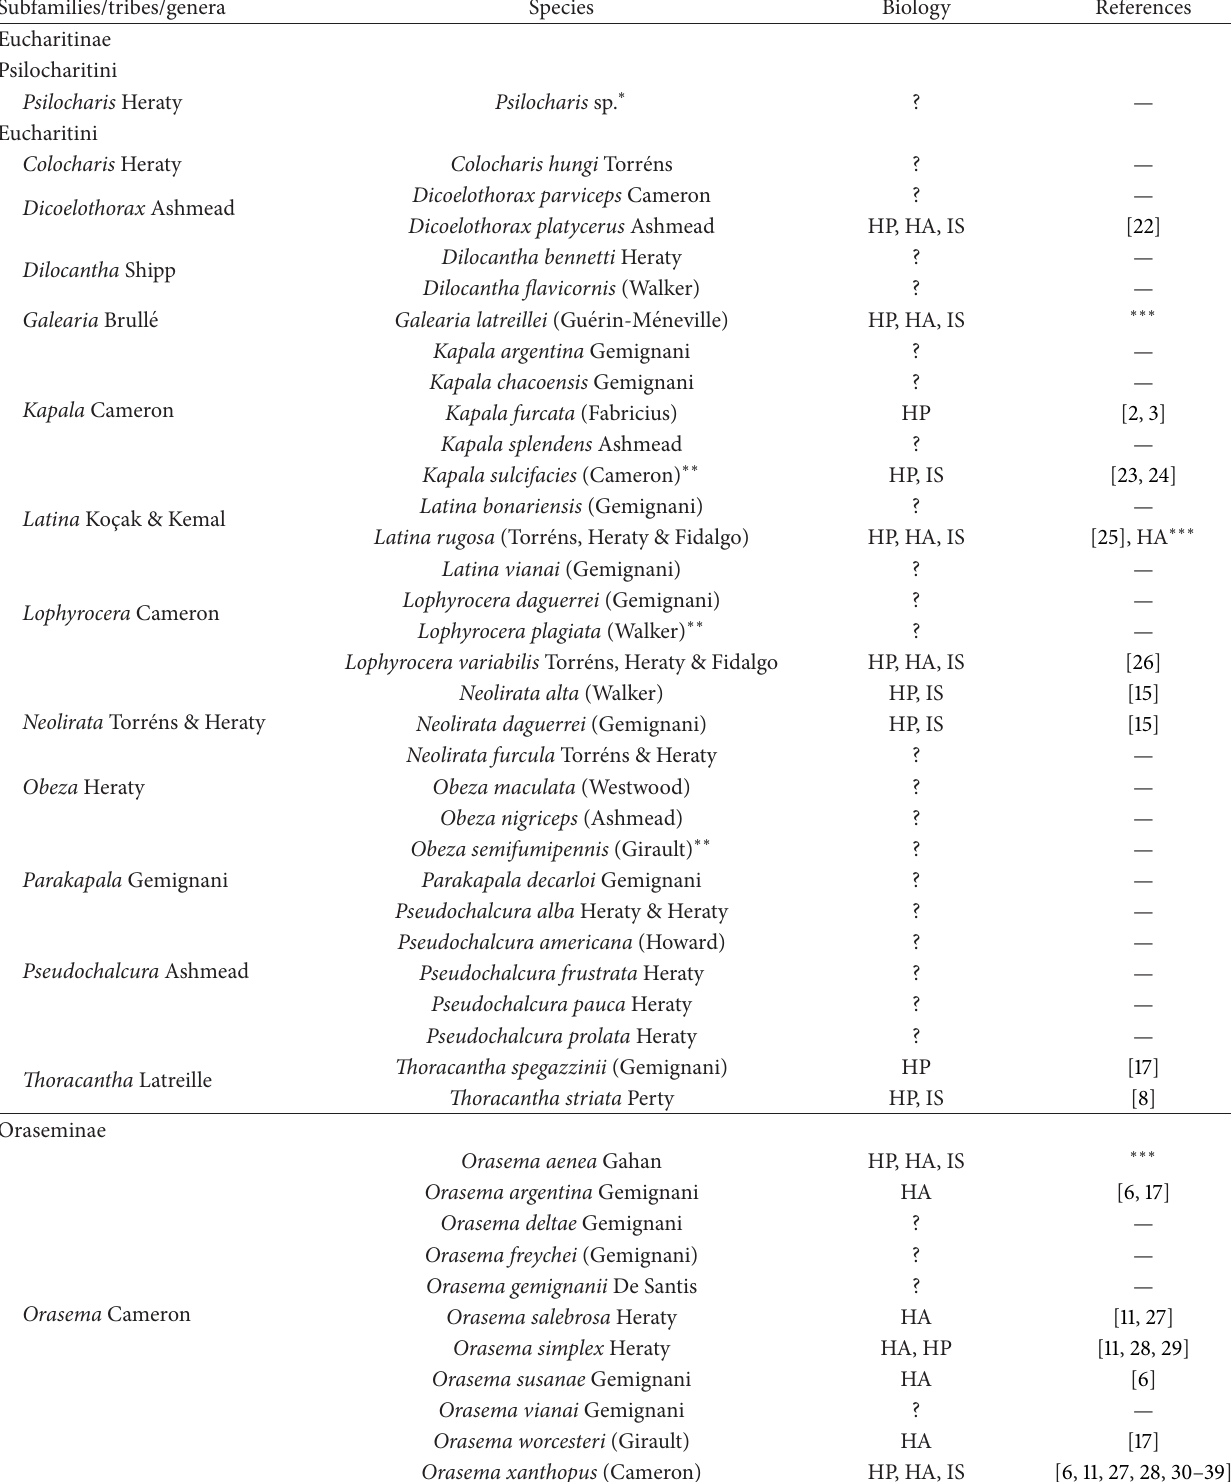
Table 1: List of species of Eucharitidae in Argentina. Known biology is indicated for host ants (HAs), host plants (HPs), or immature stages